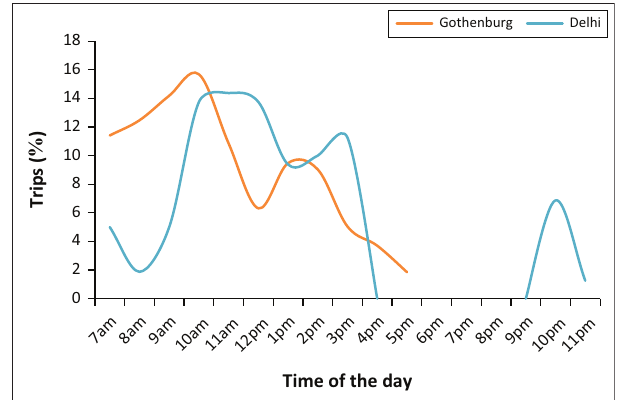
FIGURE 2: Variation of freight trips over time of the day.